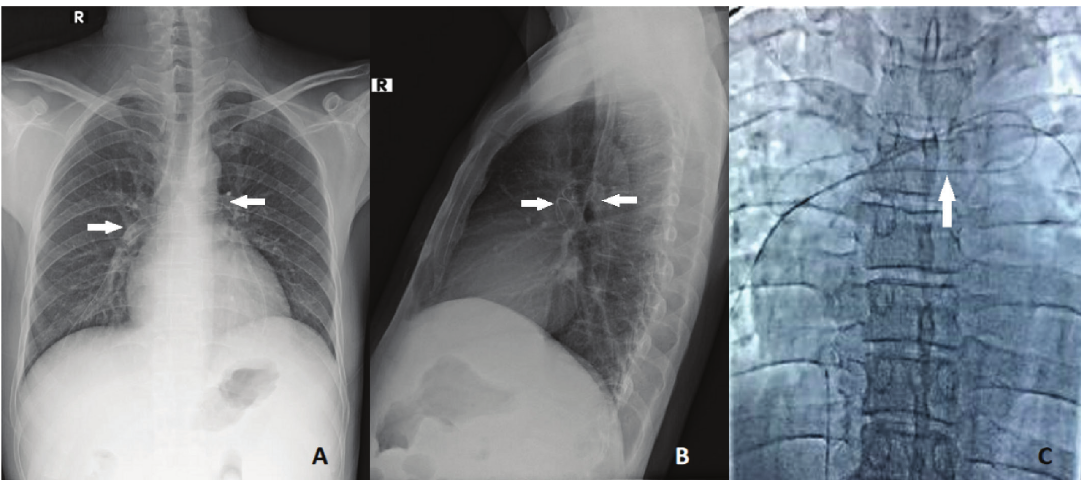
consisting of dozens of relevant specialists.